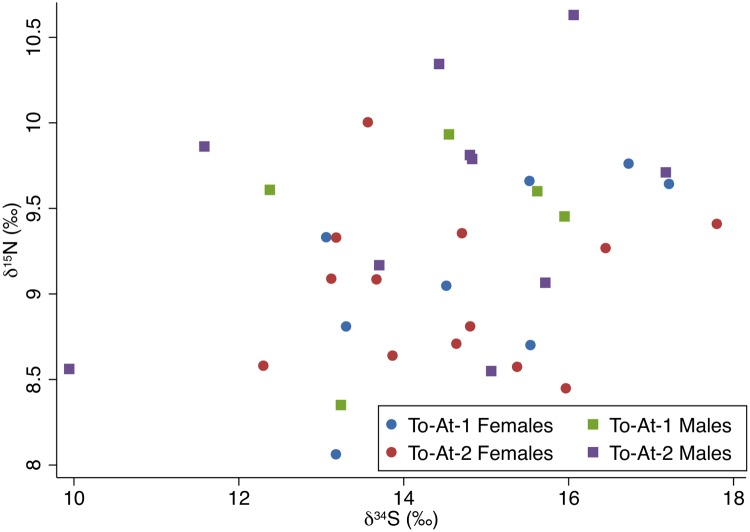
δ34S and δ15N values plotted by sex and burial mound.The δ34S outlier (To-At-2/27A) is labeled.